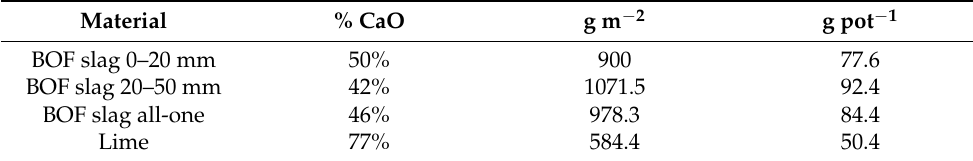
Table 5. Rate of liming material per m 2 and per pot used in the